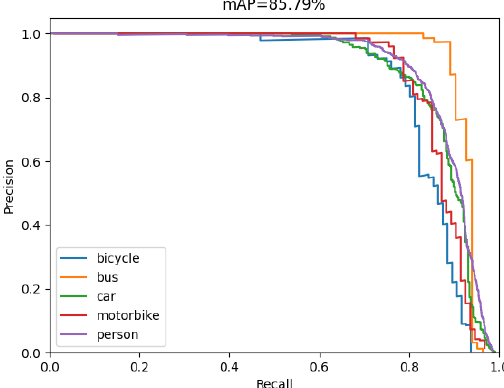
Figure 8. The mAP of Model 4 in the VOC dataset.